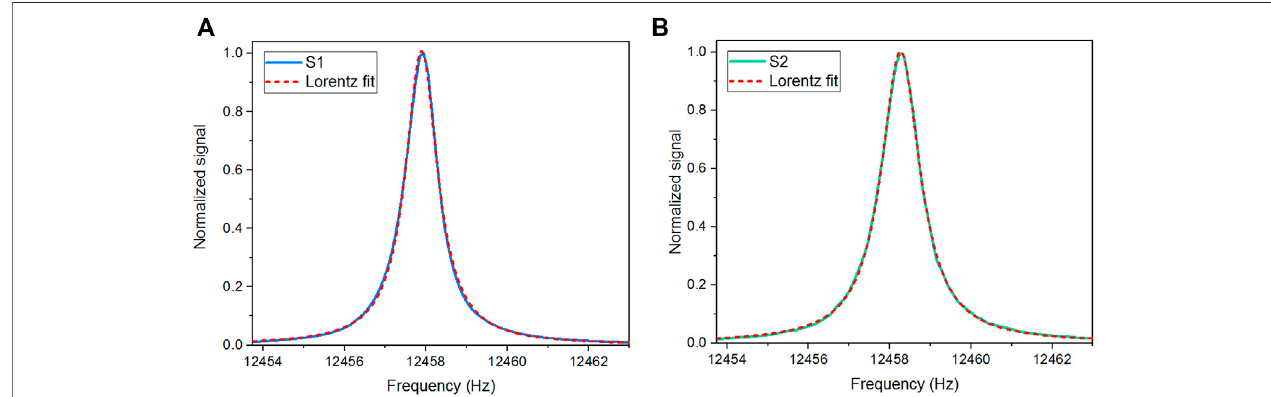
FIGURE 2 | Normalized resonance curves of the spectrophone employed in (A) S1 (blue line) and in (B) S2 (green line) measured in pure nitrogen at a working pressure of 500 Torr and at a fl ow rate of 28 sccm. Lorentzian fi t curves are represented with red dashed curves.